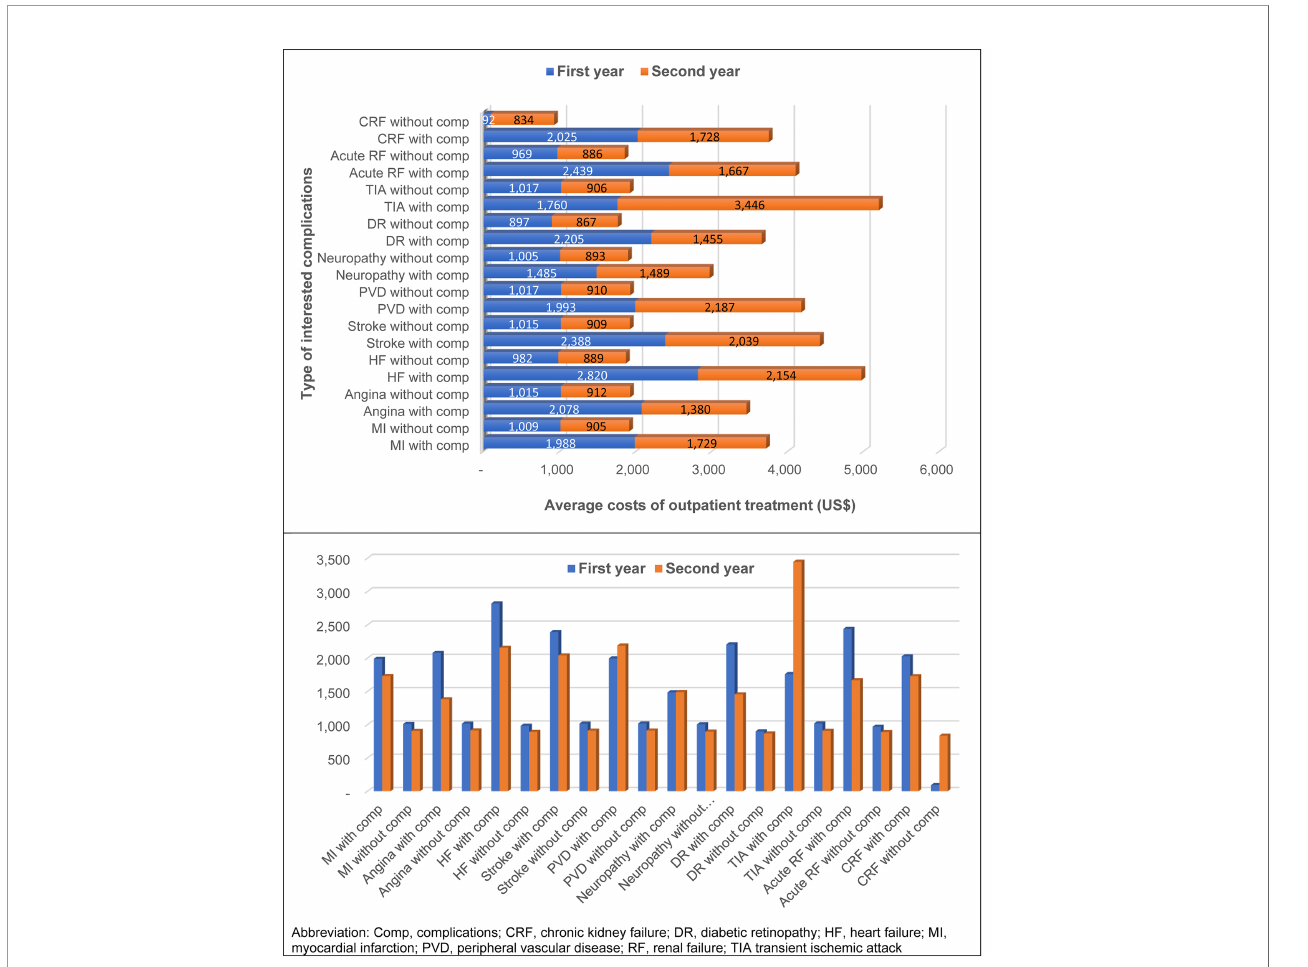
FIGURE 4 | Total treatment costs for type 2 diabetes with and without interested